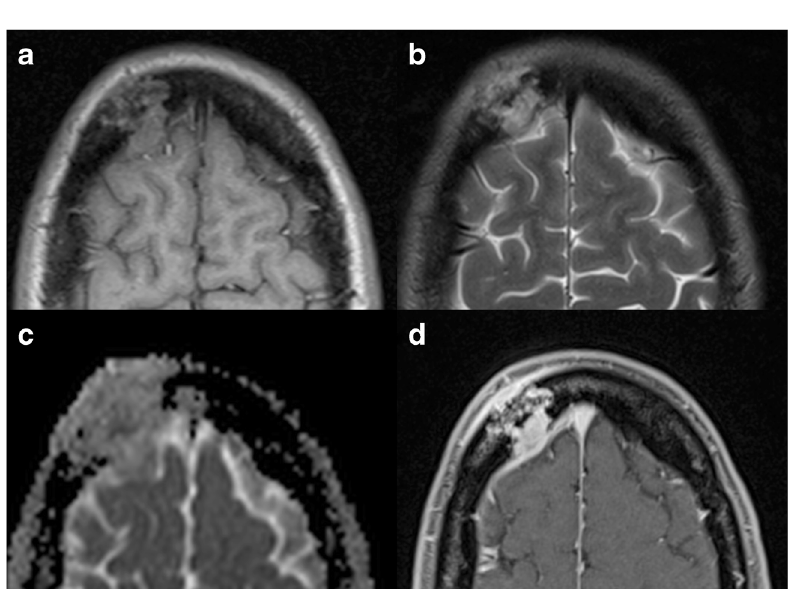
Fig. 10 EG, same patient shown inFig.9. On T1w ( a ) and T2w ( b ) images, the lesion appears mildly inhomogeneous, with diffusion restriction on the ADC map ( c